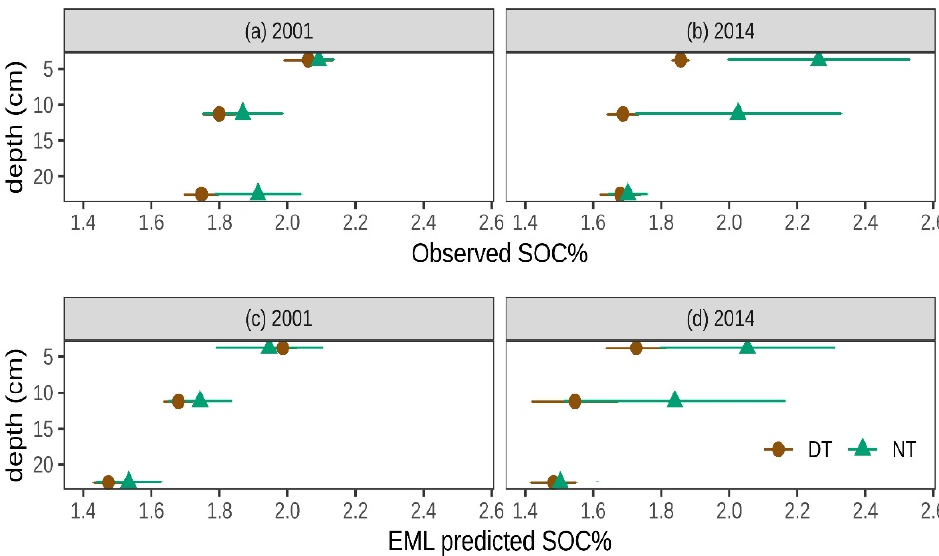
Figure 5. Lincoln-REAP trials mean and SE (n = 3) across depth (0–7.5, 7.5–15 and 15–30 cm) and years for observed ( a , b ) and EML-predicted ( c , d ) SOC%. Treatments DT— disk till with stover removal, NT—no-till with stover retention.